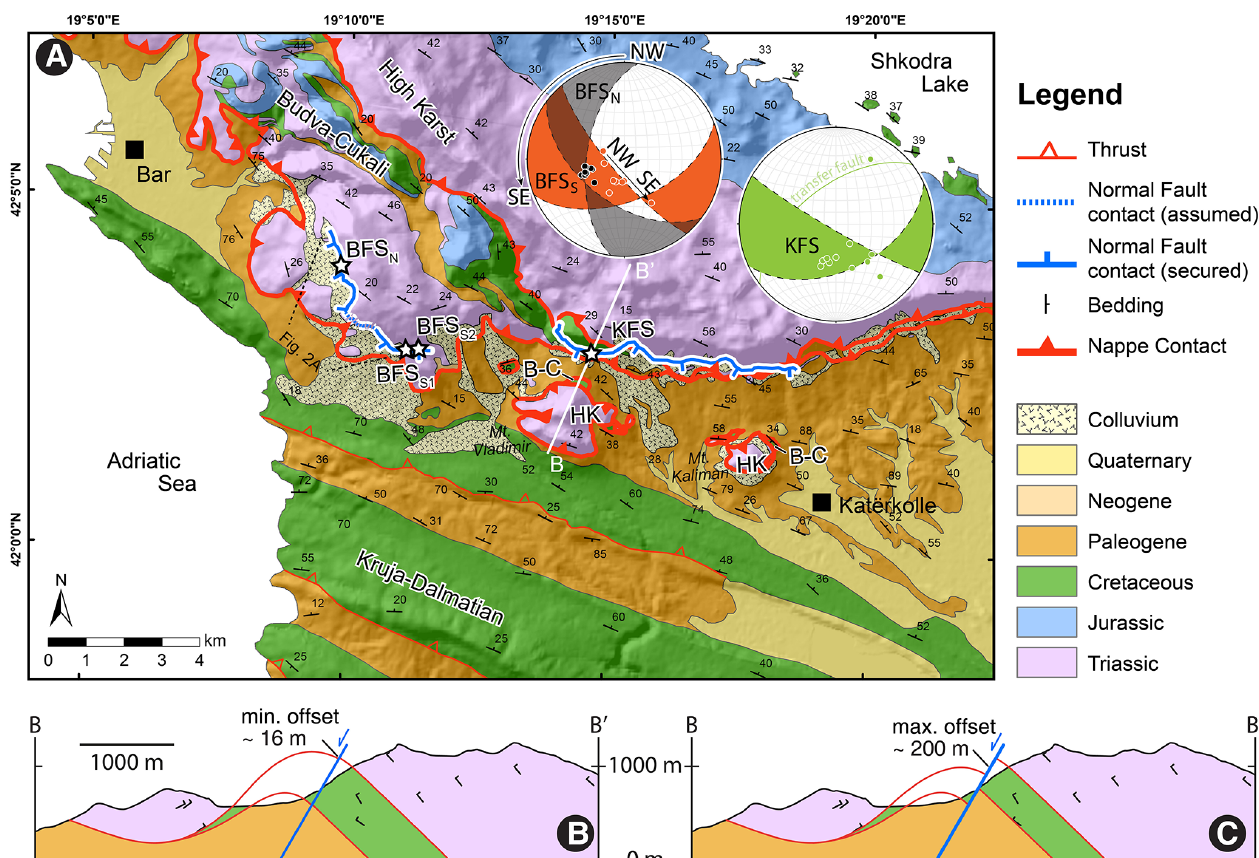
Figure 4. (a) Localization of BFS and KFS on the geological map (compiled from the 1 : 25k geological map sheet Vladimir 160-4-3 and 1 : 50k geological map sheet Podgorica 3; Geological Survey of Montenegro, 2009). Stars indicate the sites of NFS profiles (Fig. 5). Stereoplots show orientations of the fault planes and striations for BFS N (grey), BFS S (orange), and KFS (green); semi-transparent coloring – range of main fault plane orientations; dots – mean orientations of the striation. Single great circles represent (i) smaller transfer faults that connect segments of the main fault plane and (ii) the fault branch at the western end of KFS. HK: High Karst, B-C: Budva–Cukali. (b) Cross section showing the hypothetical minimum fault slip derived from the reconstructed visible fault scarp height at sampling site KFS (Fig. 5, bottom). (c) Cross section showing the proposed maximum fault slip derived from the maximum offset of the Budva–Cukali marker between the outcrops at the Vladimir nappe outlier and the Rumija